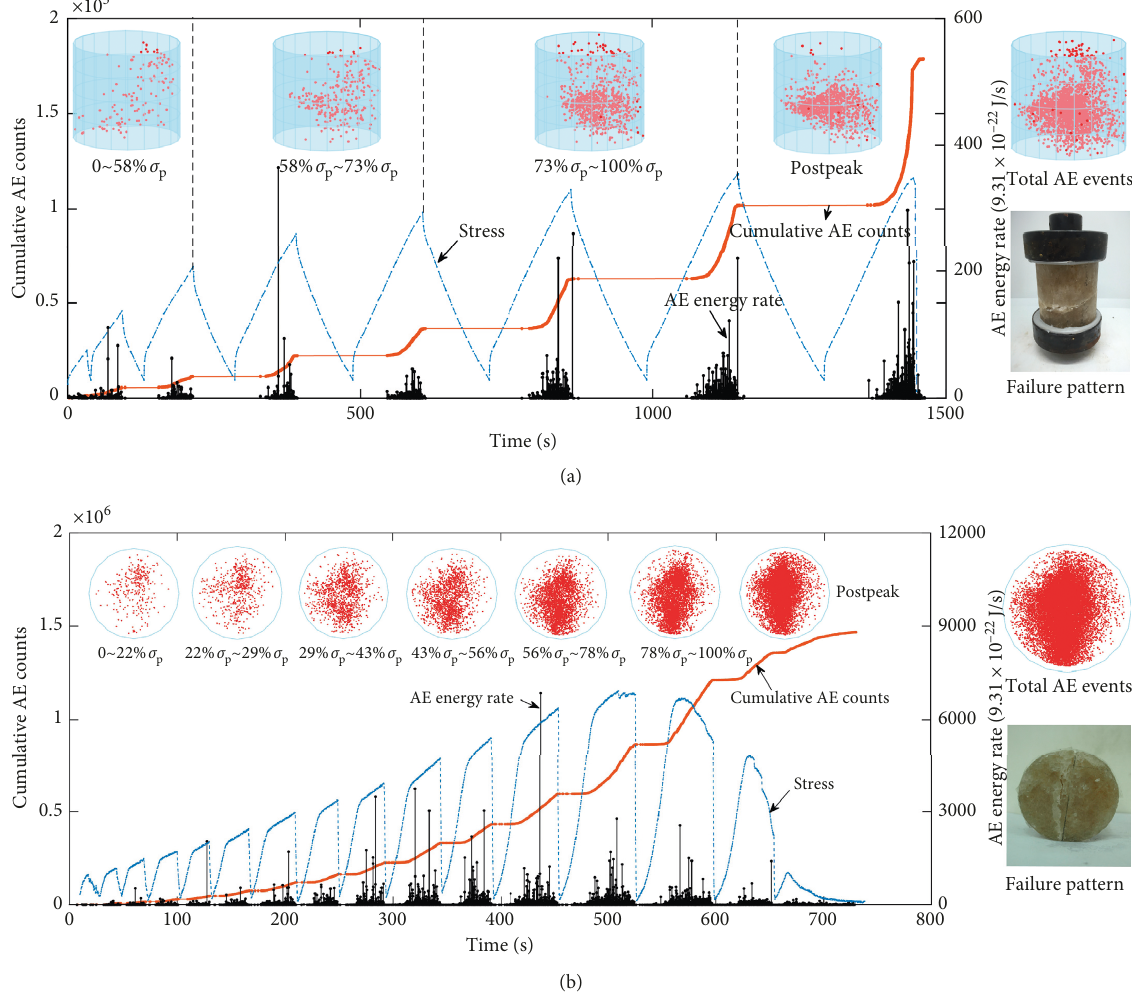
Figure 6: Evolution of AE characteristics (cumulative AE counts, AE energy rate, and spatial distribution of AE events) and failure patterns in tensile tests. (a) Direct tensile test (T-2). (b) Brazilian test